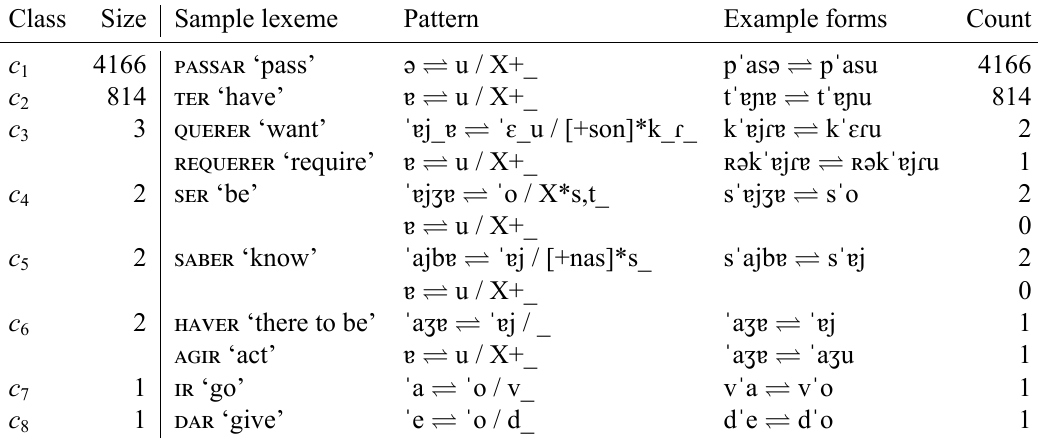
Table 10: Classes of PRS.SBJV.1SG for prediction of PRS.IND.1SG